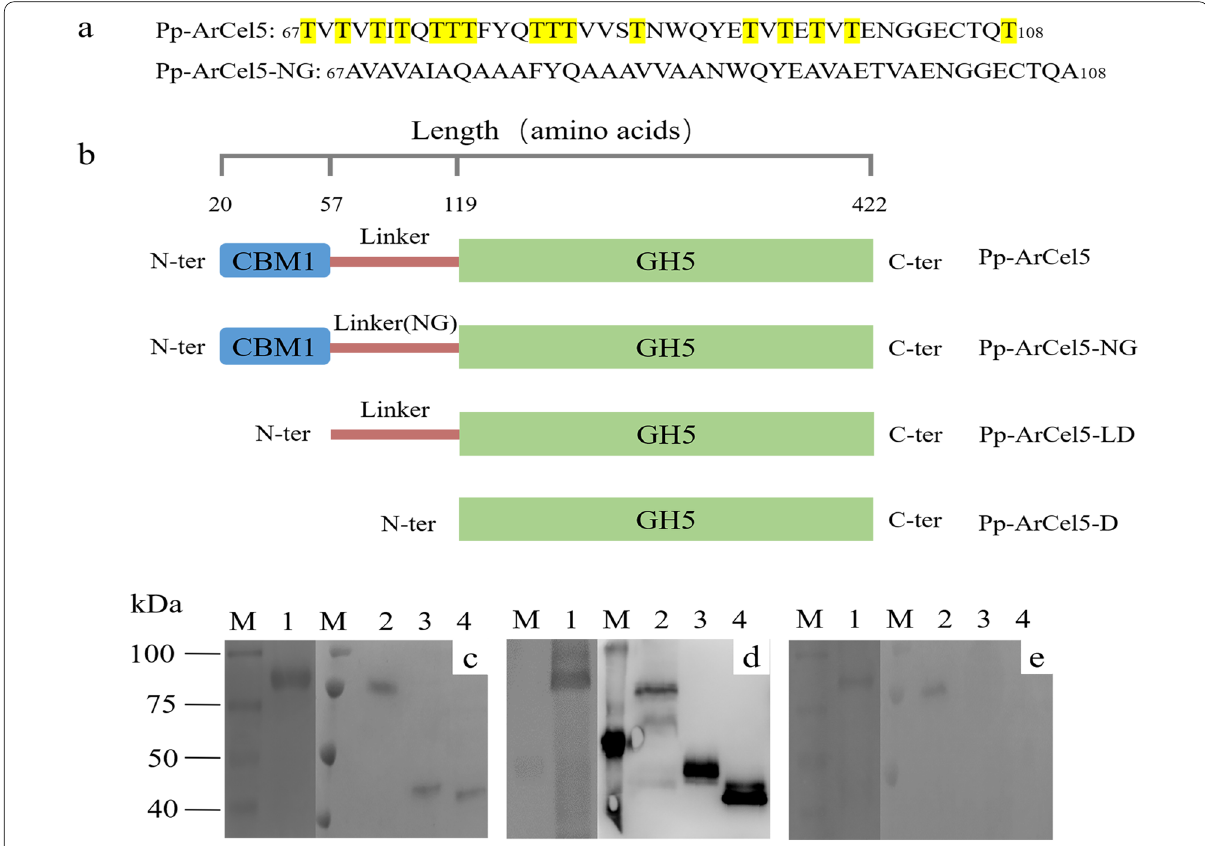
Fig. 3 Rational design and SDS-PAGE analysis of ArCel5 mutants. a Sequences of the linker regions from the 67th base to the 108th base. b Constructions of the mutants with variable lengths. c Coomassie stain, d western blot analysis, e glycoprotein stain. Lanes 1: Pp-ArCel5; lanes 2: Pp-ArCel5-LD; lanes 3: Pp-ArCel5-NG; lanes 4: